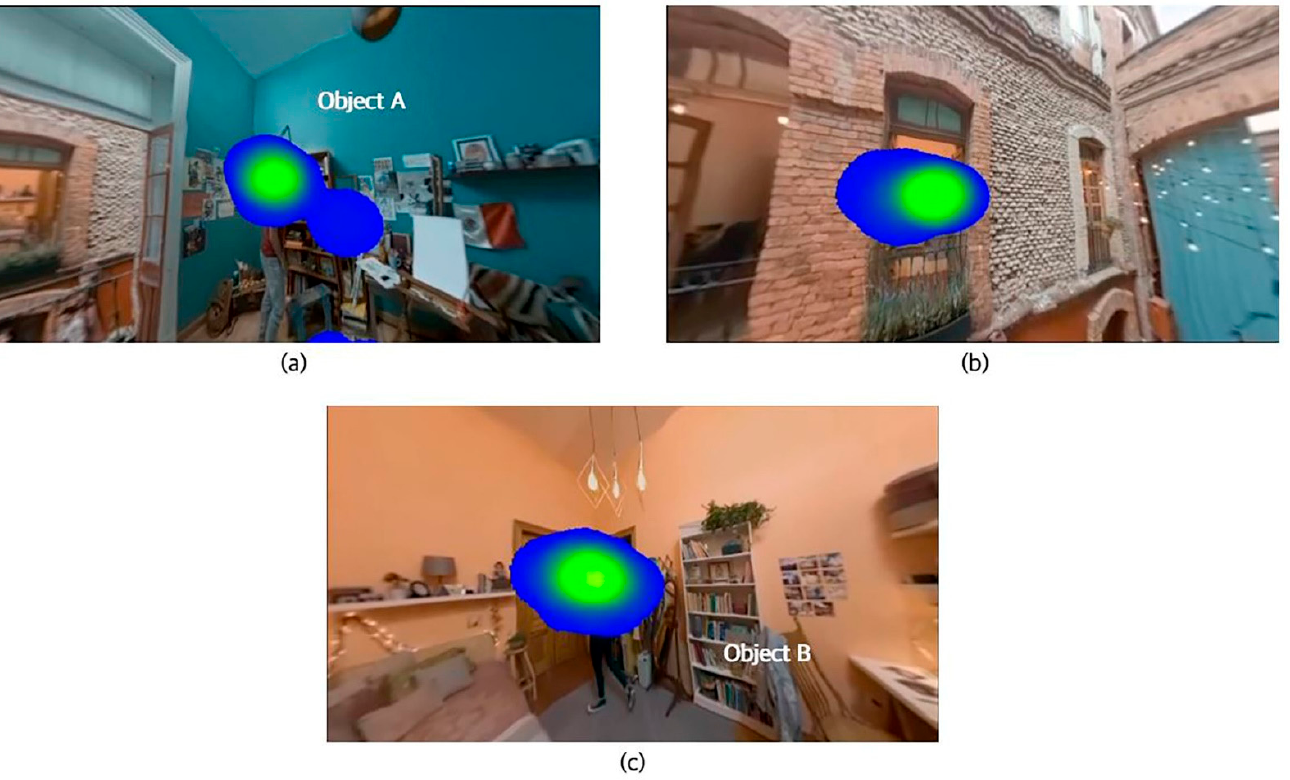
Figure 19. Eye movement according to attention-attracting element of “Camera movement”. ( a ) The subject’s attention is focused on object A before the camera moves, ( b ) When the camera starts to move, the subject’s attention moves from object A to out, ( c ) The subject’s attention moves from object A to object B.